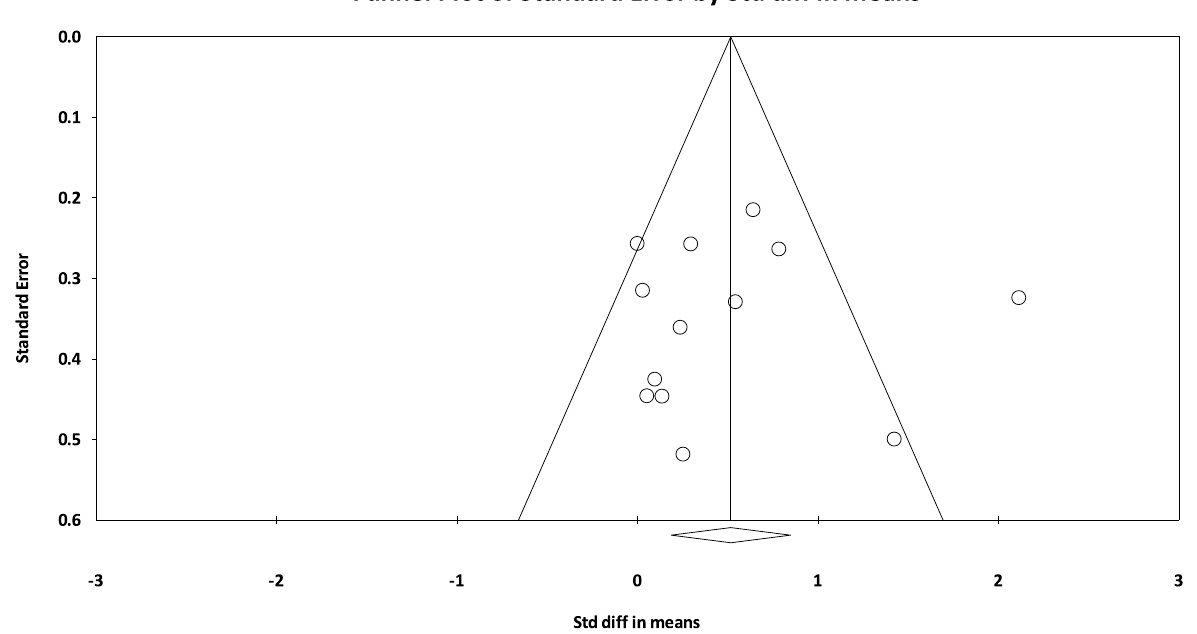
Fig. 4 The funnel plot of (RCTs and non-RCTs) studies included in the meta-analysis before and after the intervention in the control and intervention groups